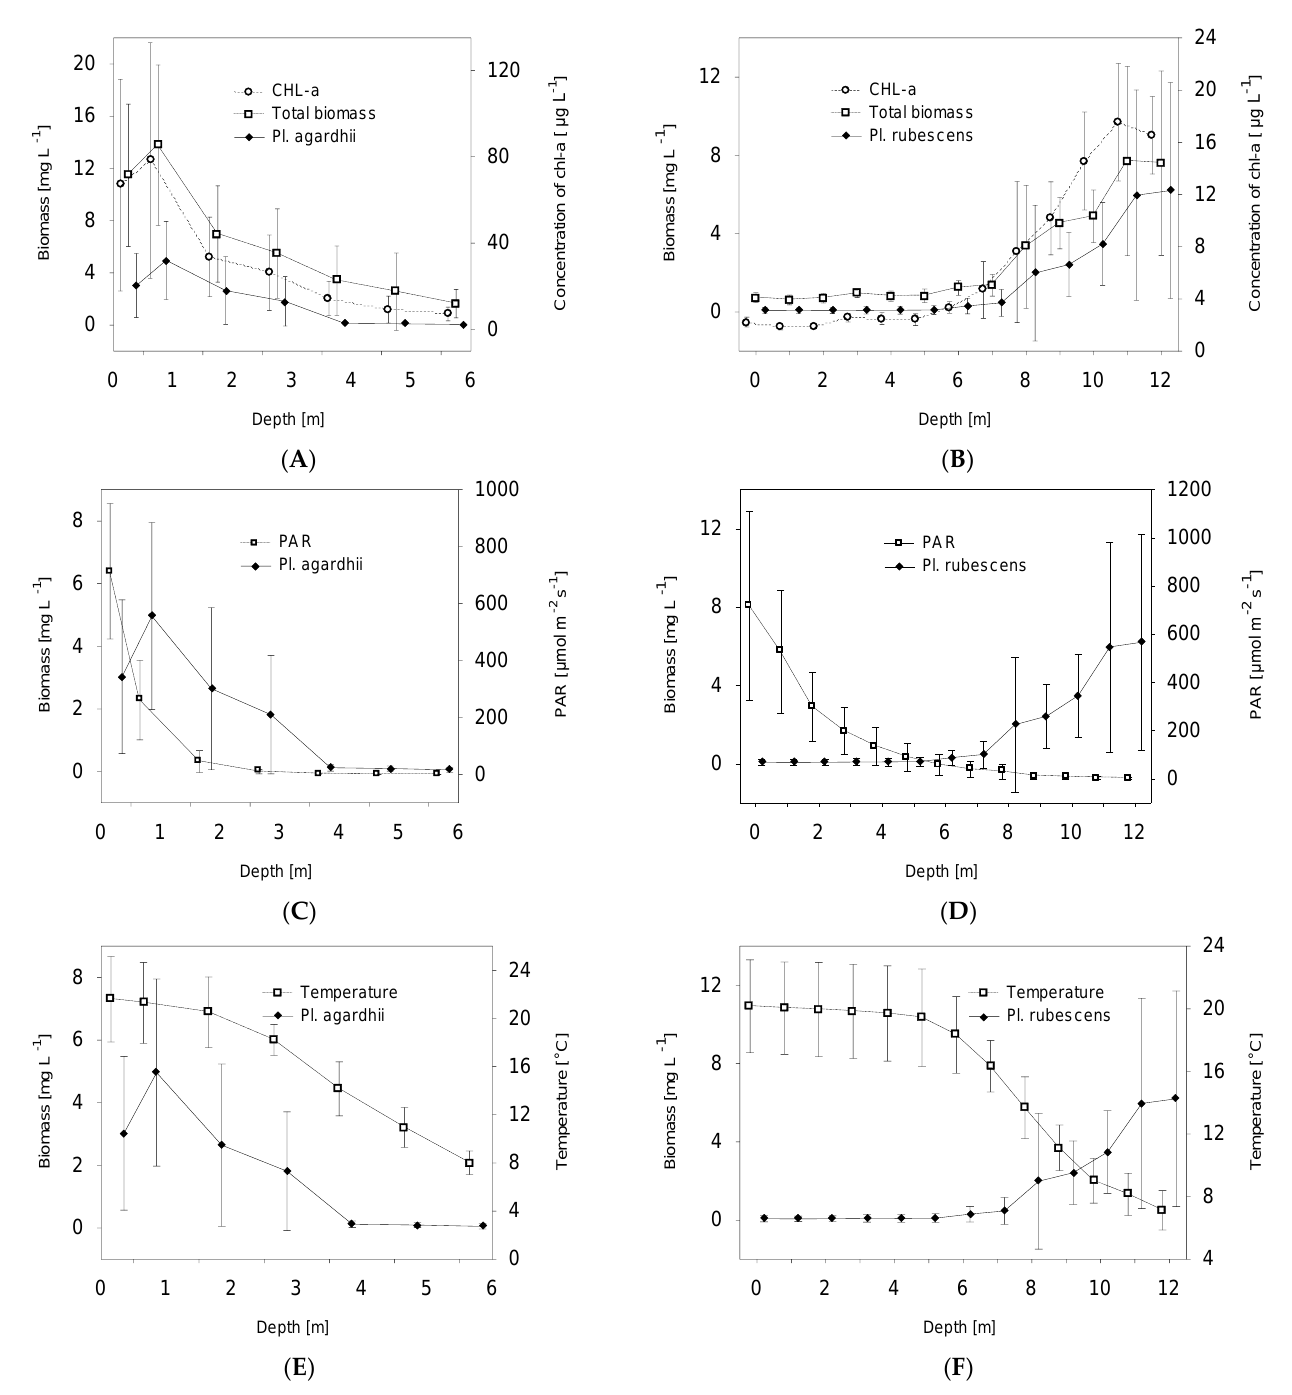
Figure 2. Mean values (±standard deviations) of selected biological and physical parameters of water in Lake Glinki ( A , C , E ) and Lake Piaseczno ( B , D , F ). Explanations: CHL- a , concentration of chlorophyll-a; PAR, photosynthetically active radiation.